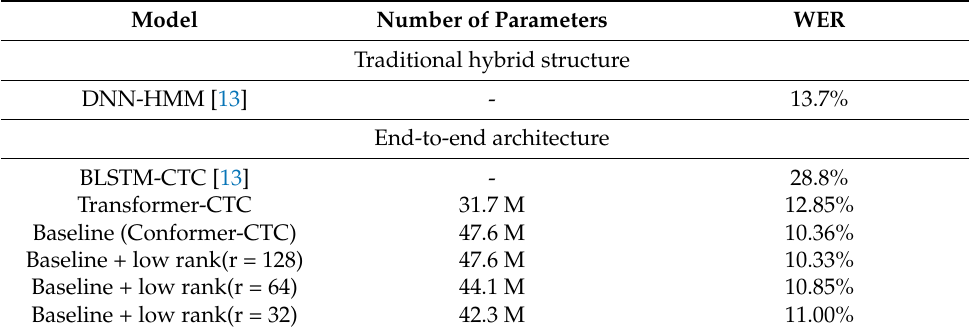
Table 2. Comparison of low rank compression and each model.